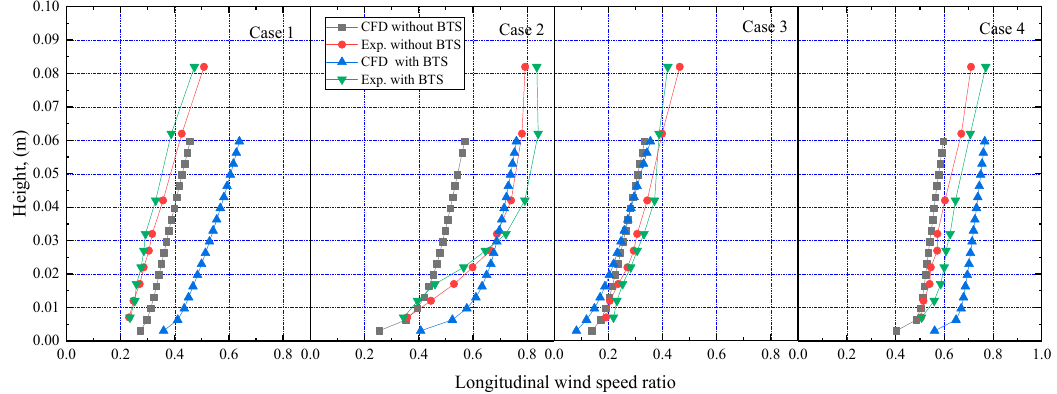
Figure 19. Numerical and experimental results of longitudinal wind speed ratio profiles at 3L/4.